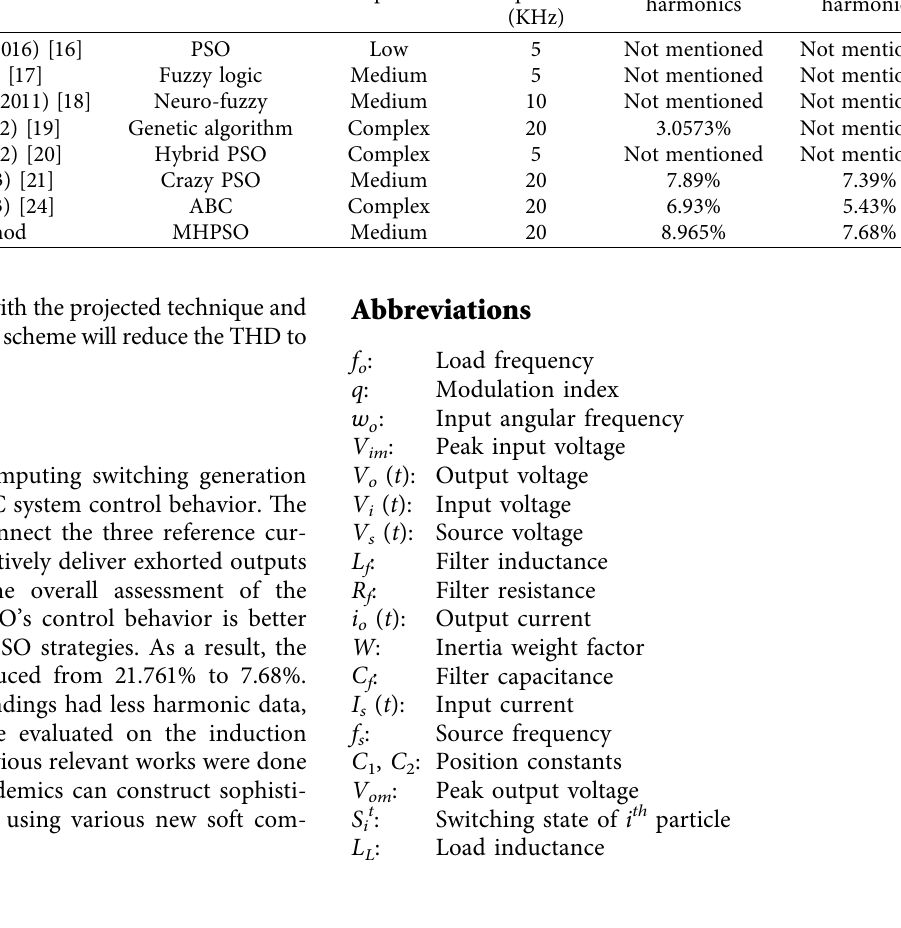
Table 5: Comparative assessment of existing methods and the proposed method. S.